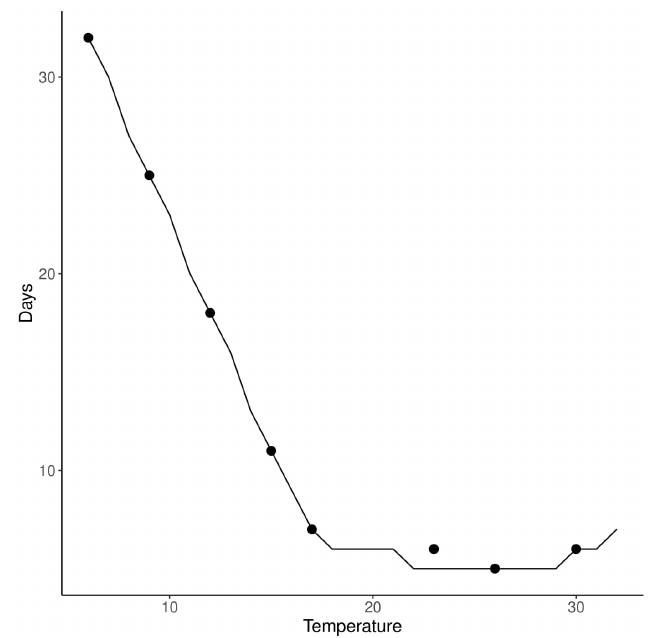
Figure 5. Number of days needed to complete a latent period responses to daily temperatures ( ◦ C). The solid line represents the estimated time to complete a latent period from Equation (9) in relation to measured days to complete a latent